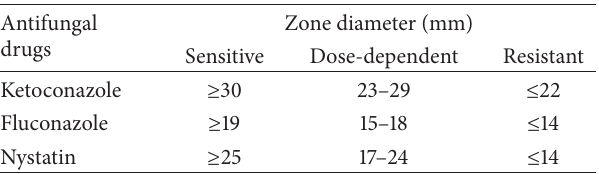
Table 2: Interpretive criteria of susceptibility and resistance to antifungals used in this study.